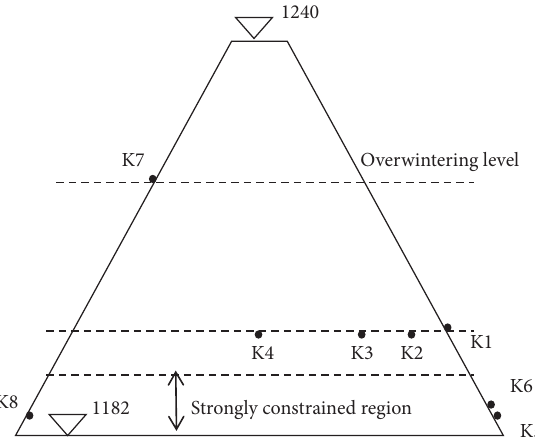
Figure 8: Position diagram of different key points of dam body.